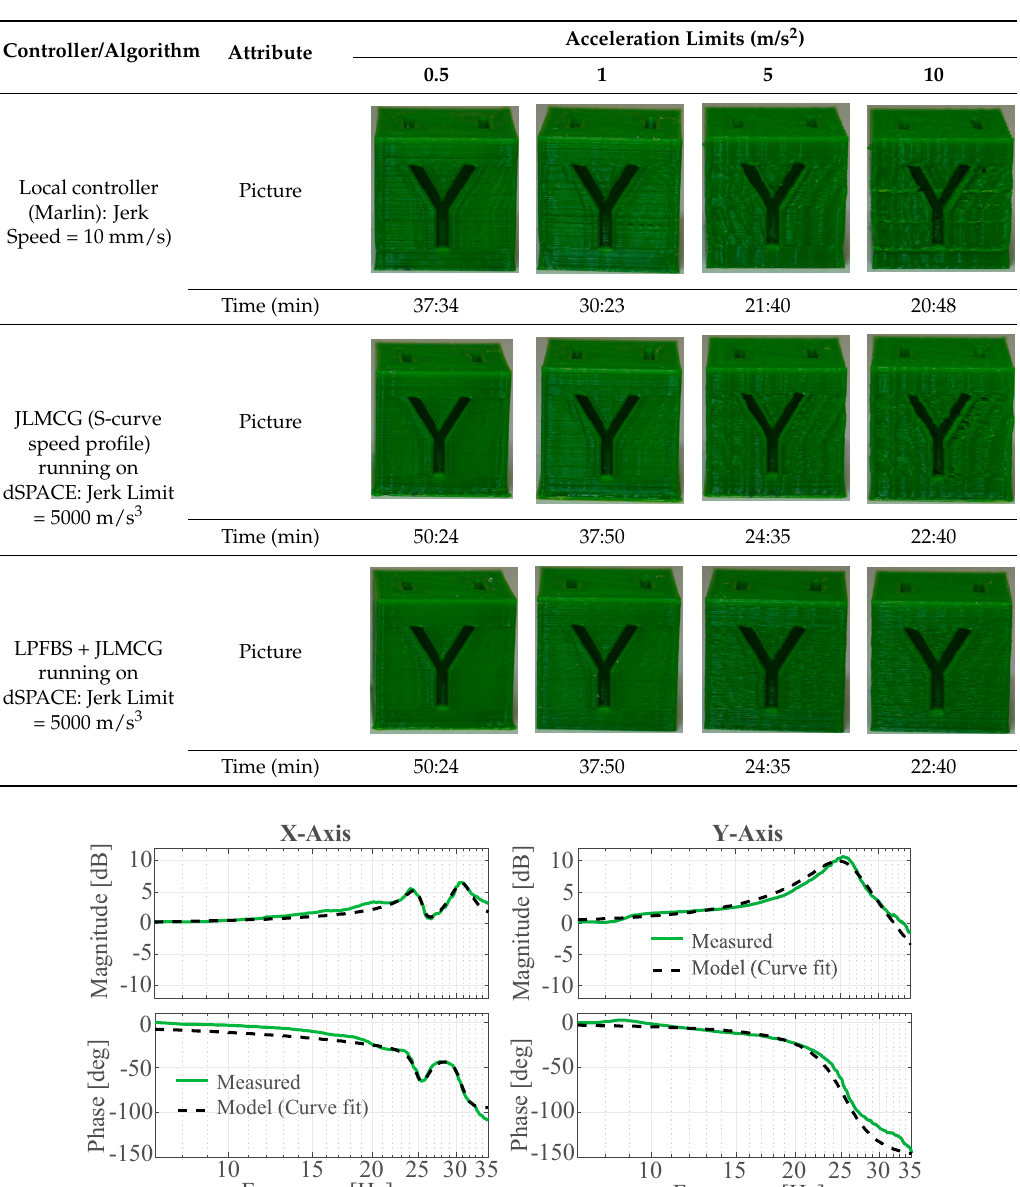
Table 3. Quality and printing time of Y-face Calibration Cube printed using the local controller (Marlin) as well as using a jerk-limited motion command generation (JLMCG) algorithm [30] (i.e., S-curve speed profile) and the limited-preview filtered B-spline (LPFBS) vibration compensation algorithm [31] both running on a high-end real-time control board (dSPACE DS1007). Note that the default acceleration limit and jerk speed of Taz 6 in Marlin are 0.5 m/s 2 and 10 mm/s, respectively.